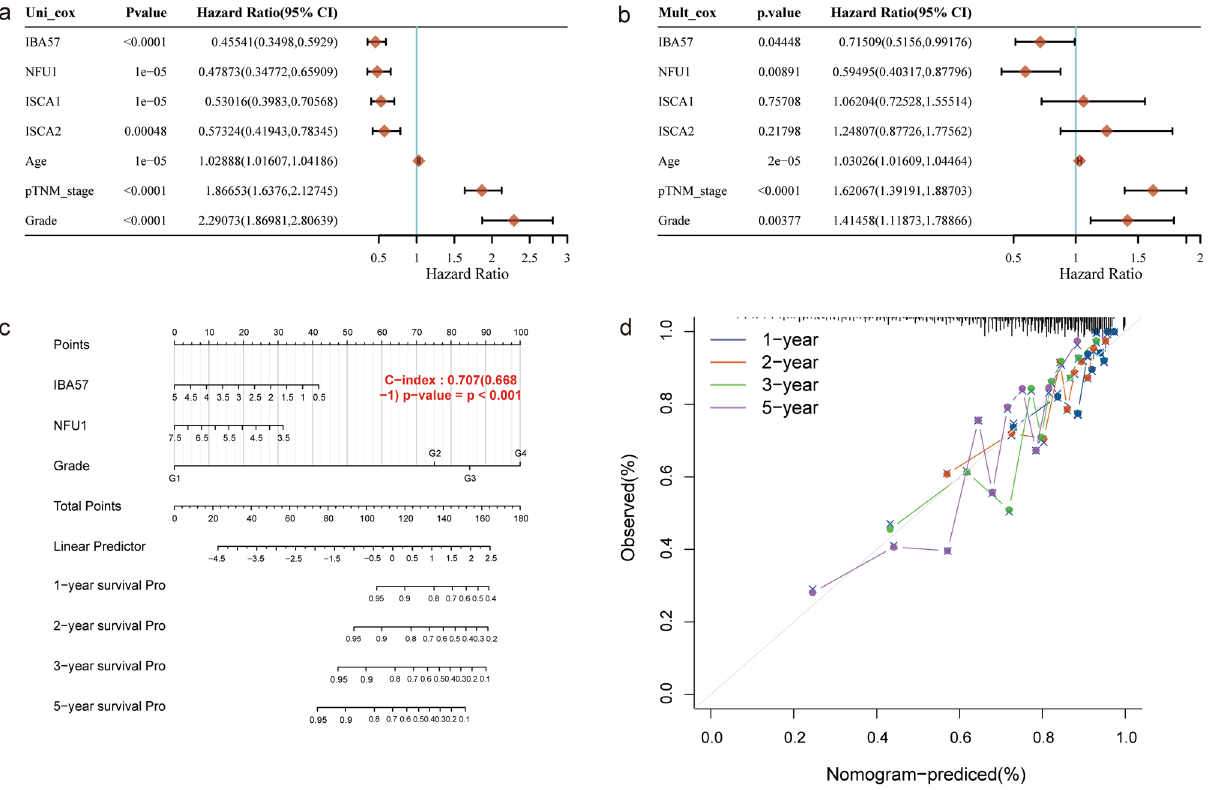
Figure 7. Construction and validation of the 4-gene signature based on the MMDS related iron–sulfur protein genes. ( a ) Univariate cox analysis of Iron–sulfur protein family genes in the TCGA-KIRC cohort. ( b ) Multivariate cox analysis of the MMDS related iron–sulfur protein genes in the TCGA-KIRC cohort. ( c ) Nomogram integrating risk score and clinical characteristics. ( d ) The 1-, 2-, 3- and 5-year calibration curves of the